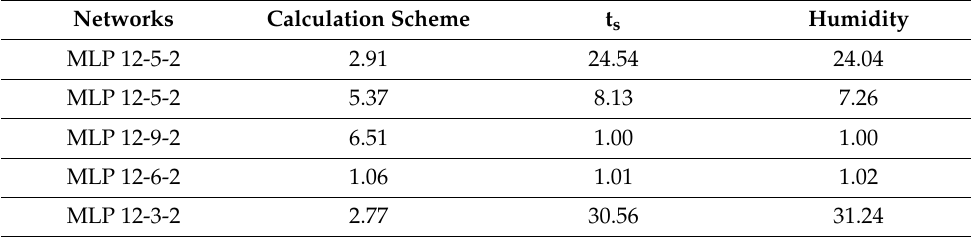
Table 5. Sensitivity